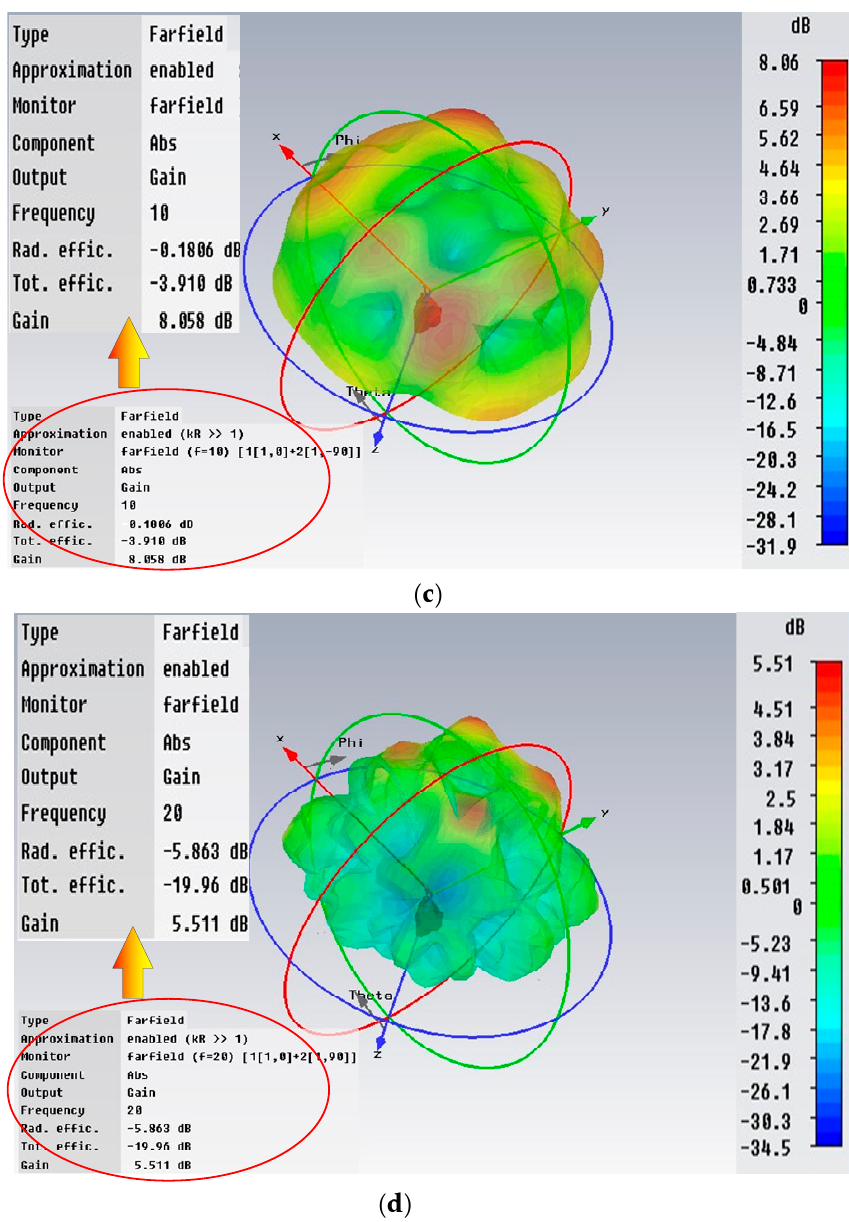
Figure 11. The pattern of the signal antenna in HF band with the impedance of 50 Ω : ( a ) 3 MHz; ( b ) 5 MHz; ( c ) 15 MHz; ( d ) 20 MHz. Although the main lobe splits as the frequency increases, it is not important for ionospheric sounding. The gain of full working band is more than 4 dB and the pointing direction is always